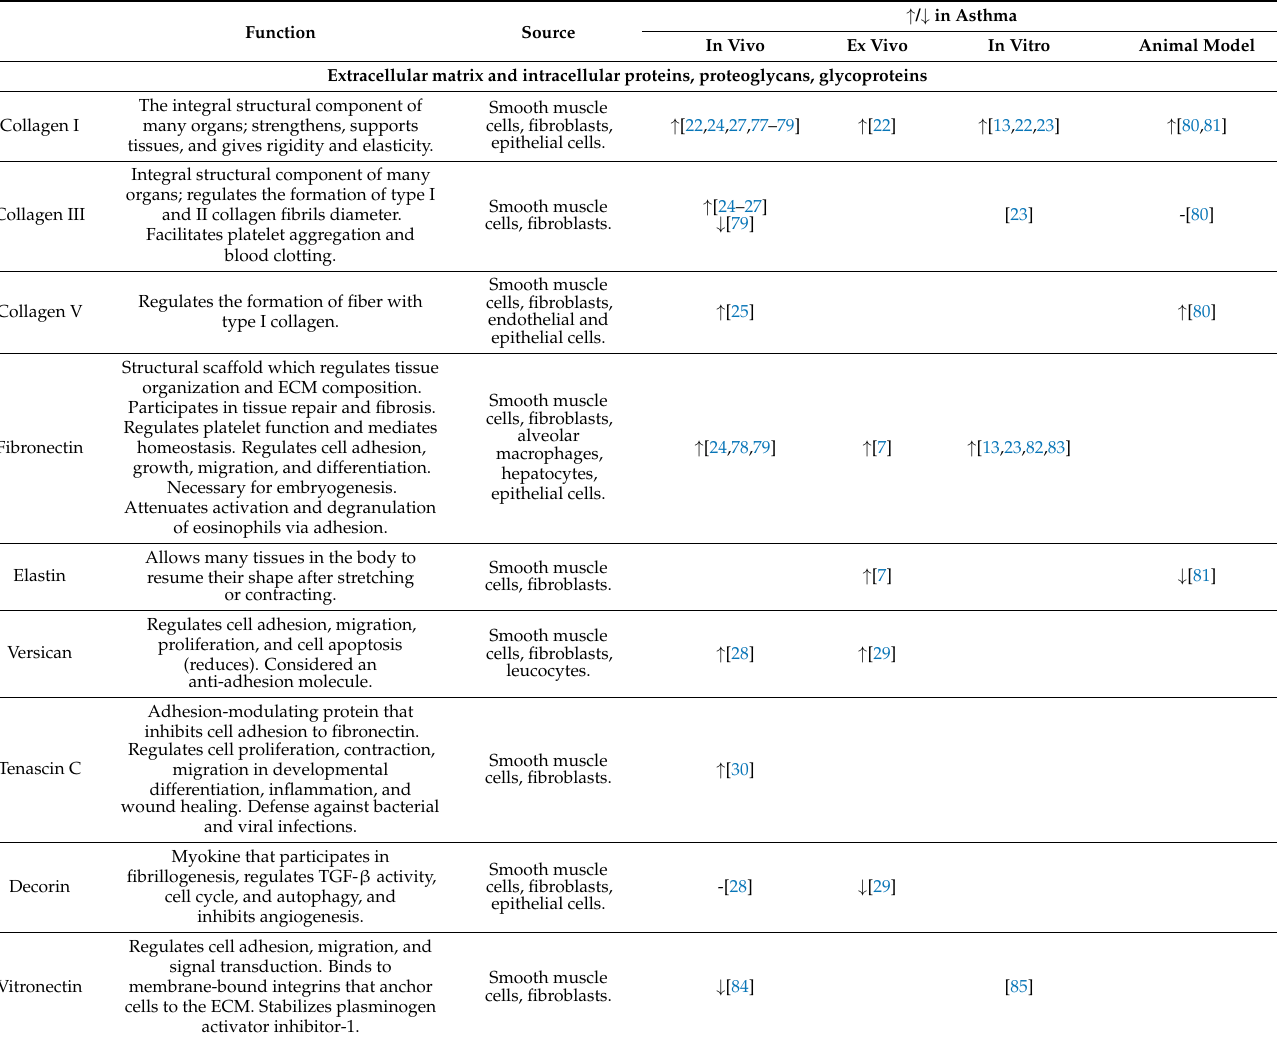
Smooth muscle cells, fibroblasts, epithelial cells.